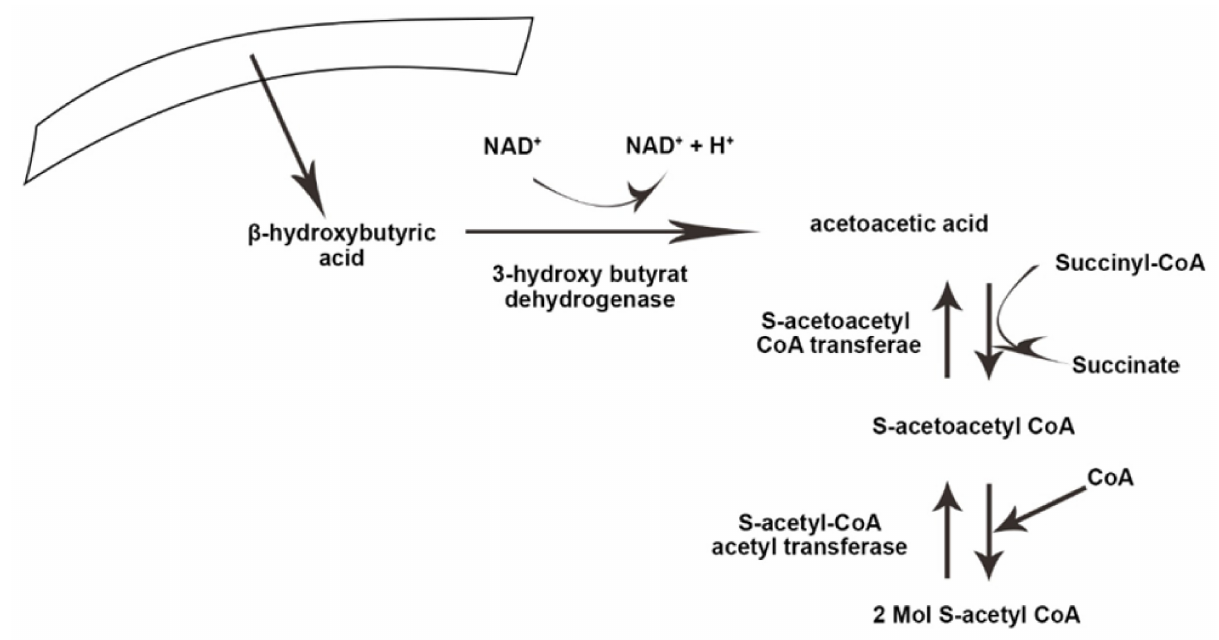
Figure 2. The process of ketolysis in the body. NAD + , Nicotinamide adenine dinucleotide. The arrows indicate the direct ion of changes in the process, as well substrates and